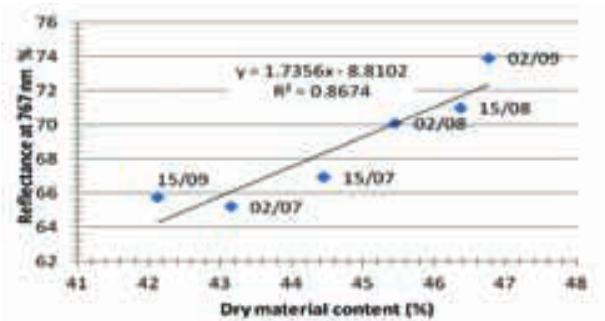
Figure 2. Correlation between reflectance at a specified spectrum with dry material